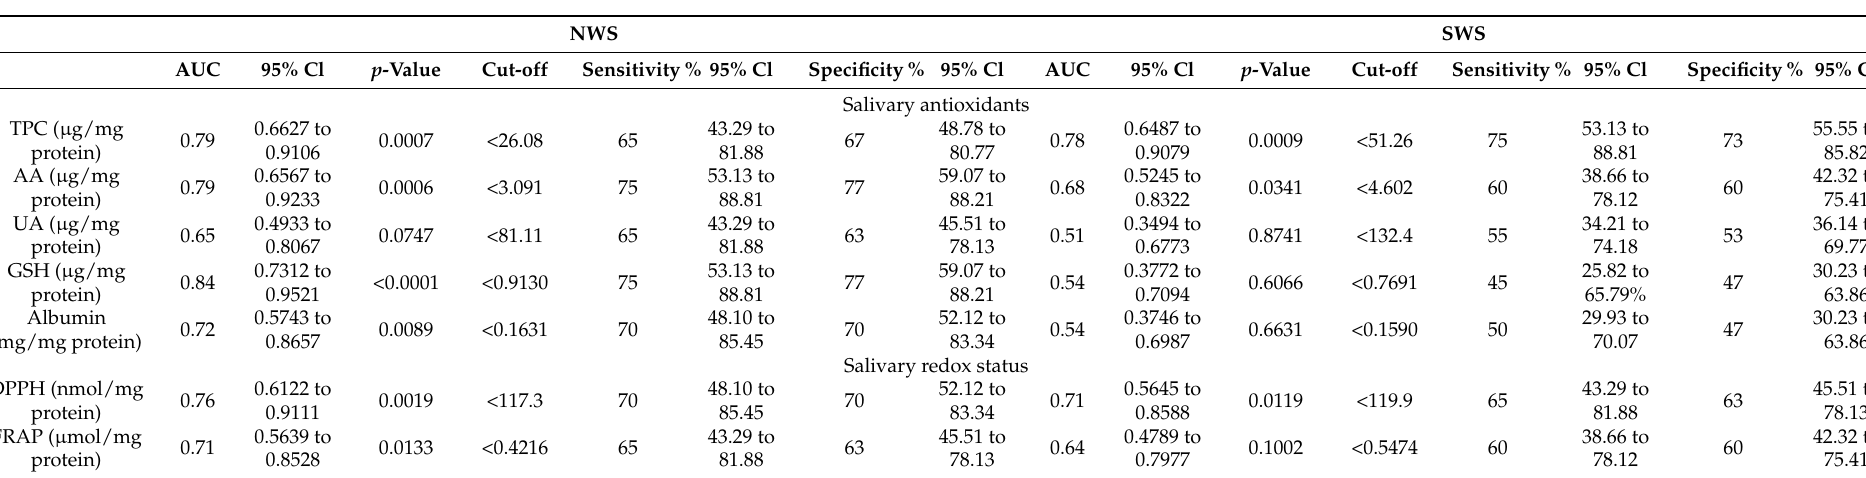
Table 6. Receiver operating characteristic (ROC) analysis of oxidative stress biomarkers in the non-stimulated and stimulated saliva of HF